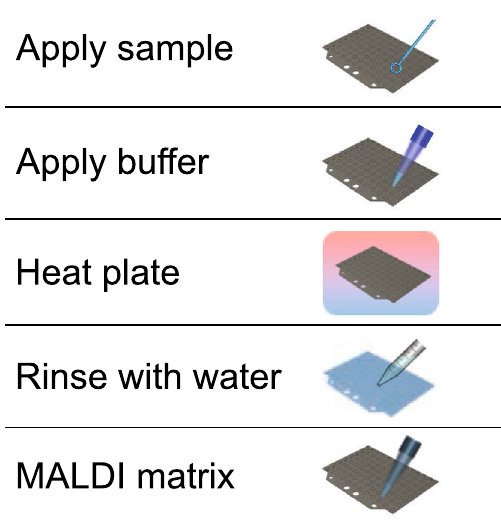
Figure 1. FLAT extraction workflow. A sample is applied to a stainless steel MALDI target plate, followed by FLAT extraction buffer (for Gram-negative species; 0.2 M anhydrous citric acid, 0.1 M trisodium citrate dihydrate) or no buffer (for Gram-positive and fungal species). The entire plate is incubated in a humidified chamber at 110 °C for 30 min and then rinsed thoroughly with water. MALDI matrix is applied to sample spots and lipid spectra are collected using MALDI-TOF